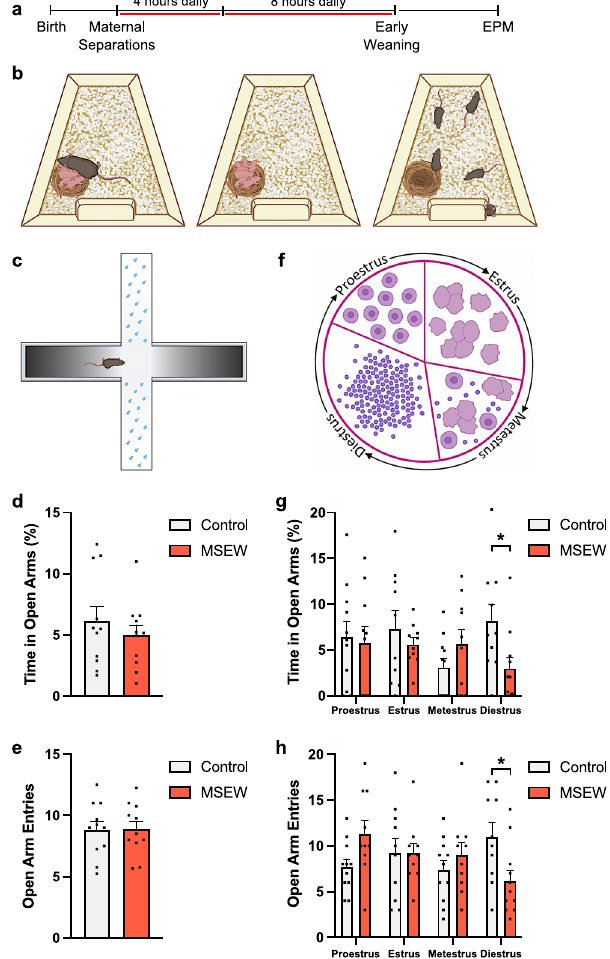
Fig. 1 | MSEW increases avoidance behavior only in diestrus. a , b Timeline and schematicsofMSEWparadigm. c Schematicofthemodi fi edEPM,witha fi nemistof water sprayed on the open arms to increase avoidance and prevent habituation with repeated trials. d Percent time in the open arms of the modi fi ed EPM is not signi fi cantly different between control and MSEW mice when stage of estrous during testing is not taken into consideration (Control n =11, MSEW n =11). e Number of entries into the open arm between control and MSEW mice is not signi fi cantly different when stage of estrous during testing is not taken into con- sideration (Control n =11, MSEW n =11). f Schematic of vaginal cytology used to determine whether mice were in different stages of the estrous cycle (proestrus, estrus,metestrus,anddiestrus). g Testingonthemodi fi edEPMatspeci fi cstagesof the estrous cycle shows that during diestrus, MSEW mice display increased avoidance behavior, i.e., reduced percent time in the open arms, compared to control mice ( F 3,55 =3.393, p =0.0242; Control-MSEW Diestrus p =0.0464; Control n =11, MSEW n =11). h MSEW mice also have signi fi cantly fewer entries into the open arm while in diestrus ( F 3,55 =4.153, p =0.0101; Control-MSEW Diestrus p=0.0350;Control n =11,MSEW n =11).Nosigni fi cantdifferencesbetweencontrol and MSEW mice were observed during proestrus, estrus, or metestrus. MSEW= maternal separation early weaning. * p <0.05 two-sided unpaired t -tests ( d , e ); mixed-effects model repeated measures followed by Š idák post hoc tests ( g , h